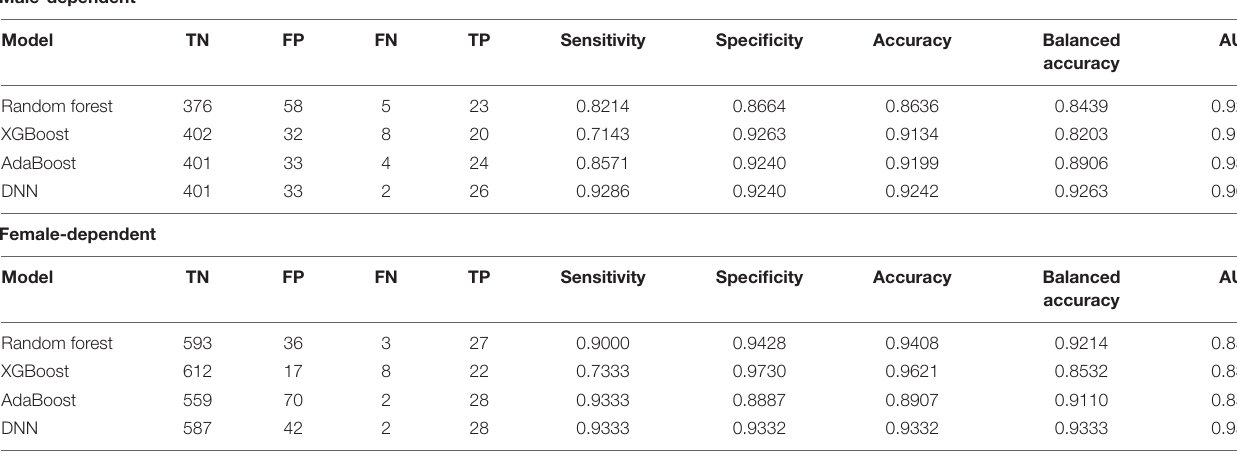
TABLE 4 | Testing data results from the same gender data. Male-dependent Model